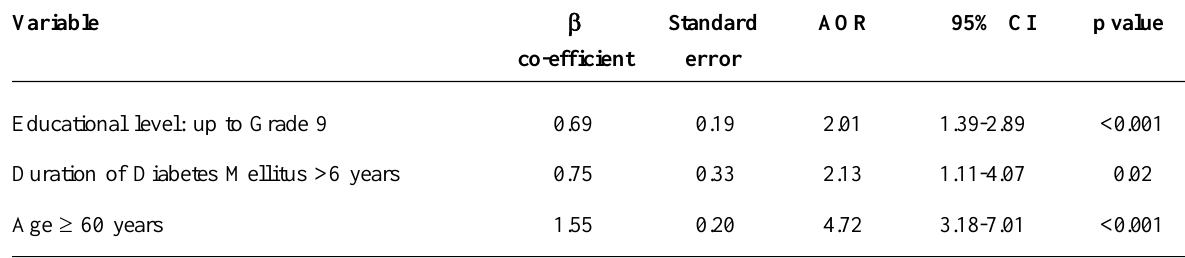
Table 3. Adjusted odds ratios of the factors associated with